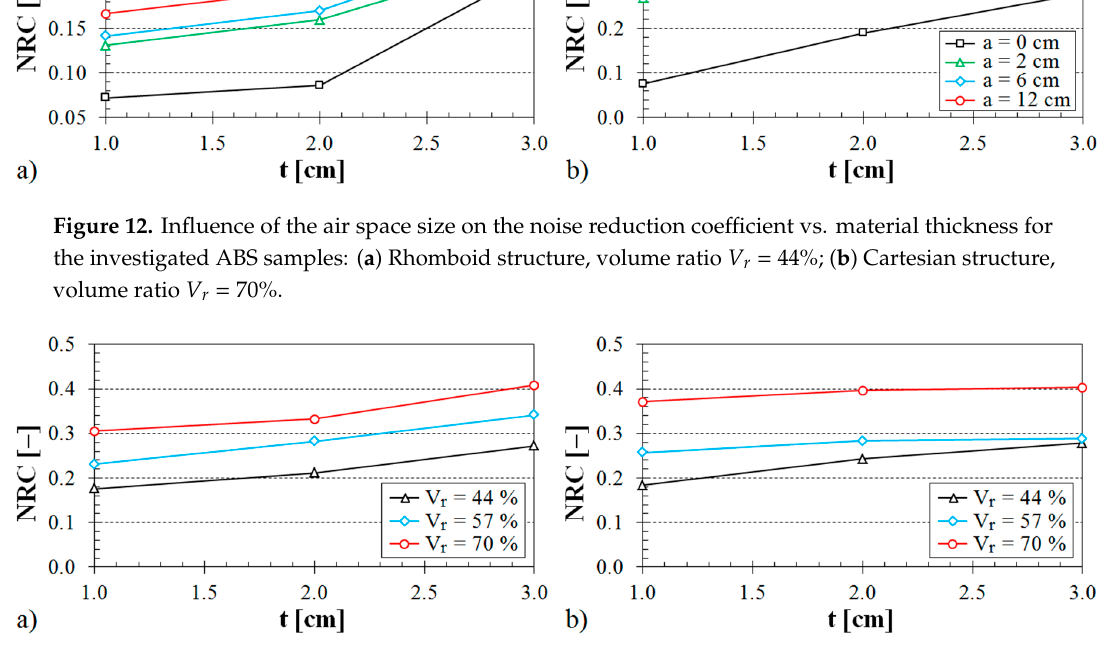
Figure 14. Influence of the 3D-printed ABS material structure on the noise reduction coefficient vs. volume ratio for the investigated ABS samples: ( a ) sample thickness t = 3 cm, air space size a = 10 cm; ( b ) sample thickness t = 1 cm, air space size a = 4 cm.